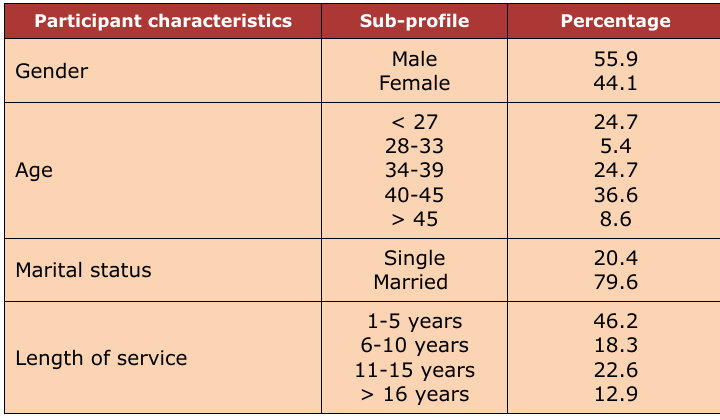
Table 1. Participant characteristics (n =